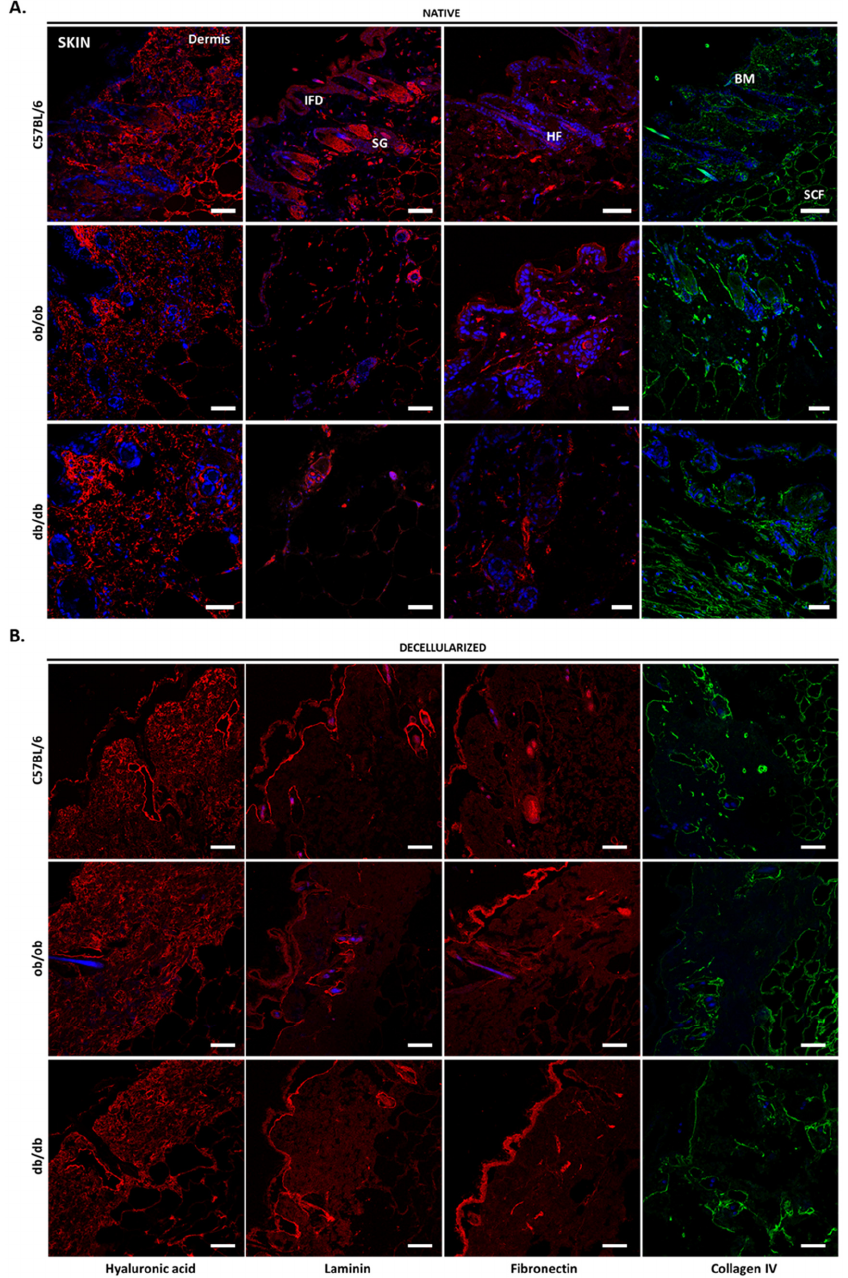
Figure 4. ECM components of the skin before and after decellularization. Visualization of native ( A ) and decellularized ( B ) skin sections from C57BL/6J, ob/ob, and db/db mice. The representative results compare confocal microscopy images of hyaluronic acid (first column), laminin (second columns), fibronectin (third column), and collagen IV (forth column) immunostained skin samples. Nuclei are shown in blue after DAPI counterstaining. Mouse hair may also be observed in blue as it emits light in the blue spectral range. IFD, interfollicular dermis; SG, sebaceous gland; HF, hair follicle; BM, basement membrane; SCF, subcutaneous fat layer. Scale bar: 50 µ